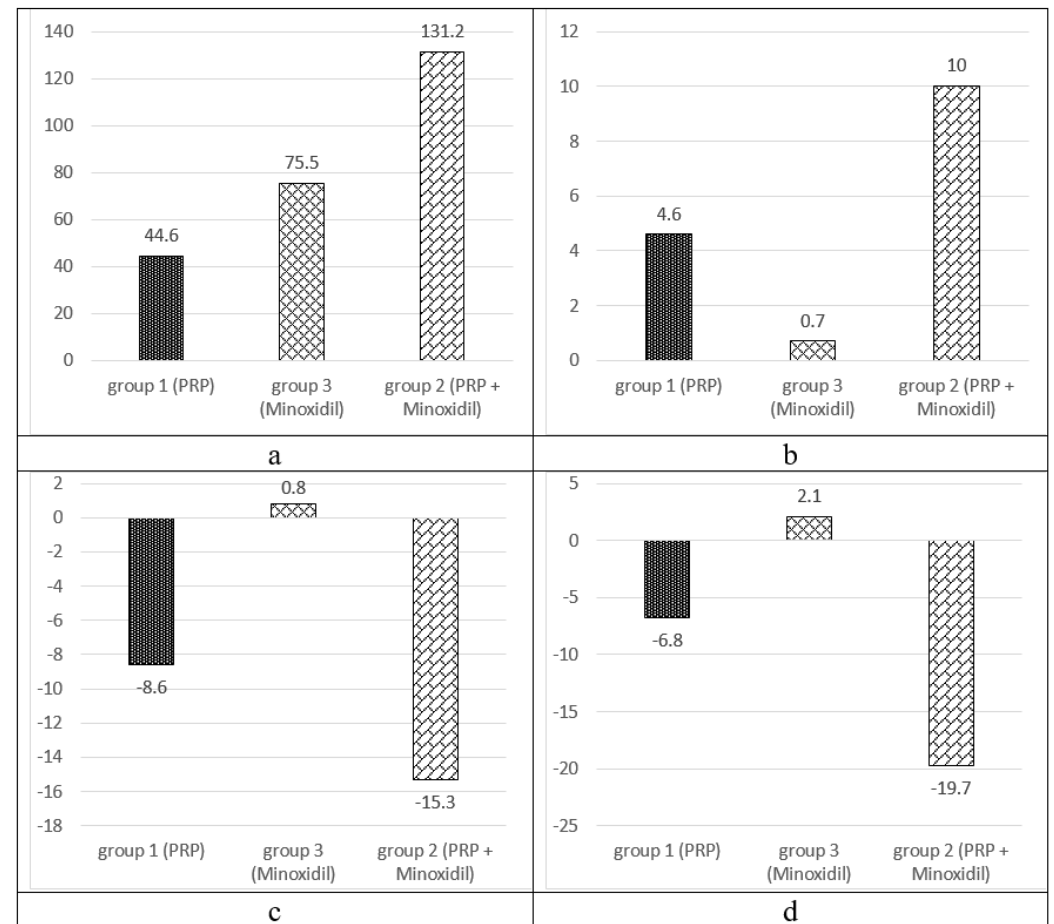
Figure 4. Dynamics of morphometric indicators of hair growth: hair density on 1 cm 2 ( a ), average diameter of all hair, μm ( b ), share of telogen hair, % ( c ), share of vellus hair, % ( d ).